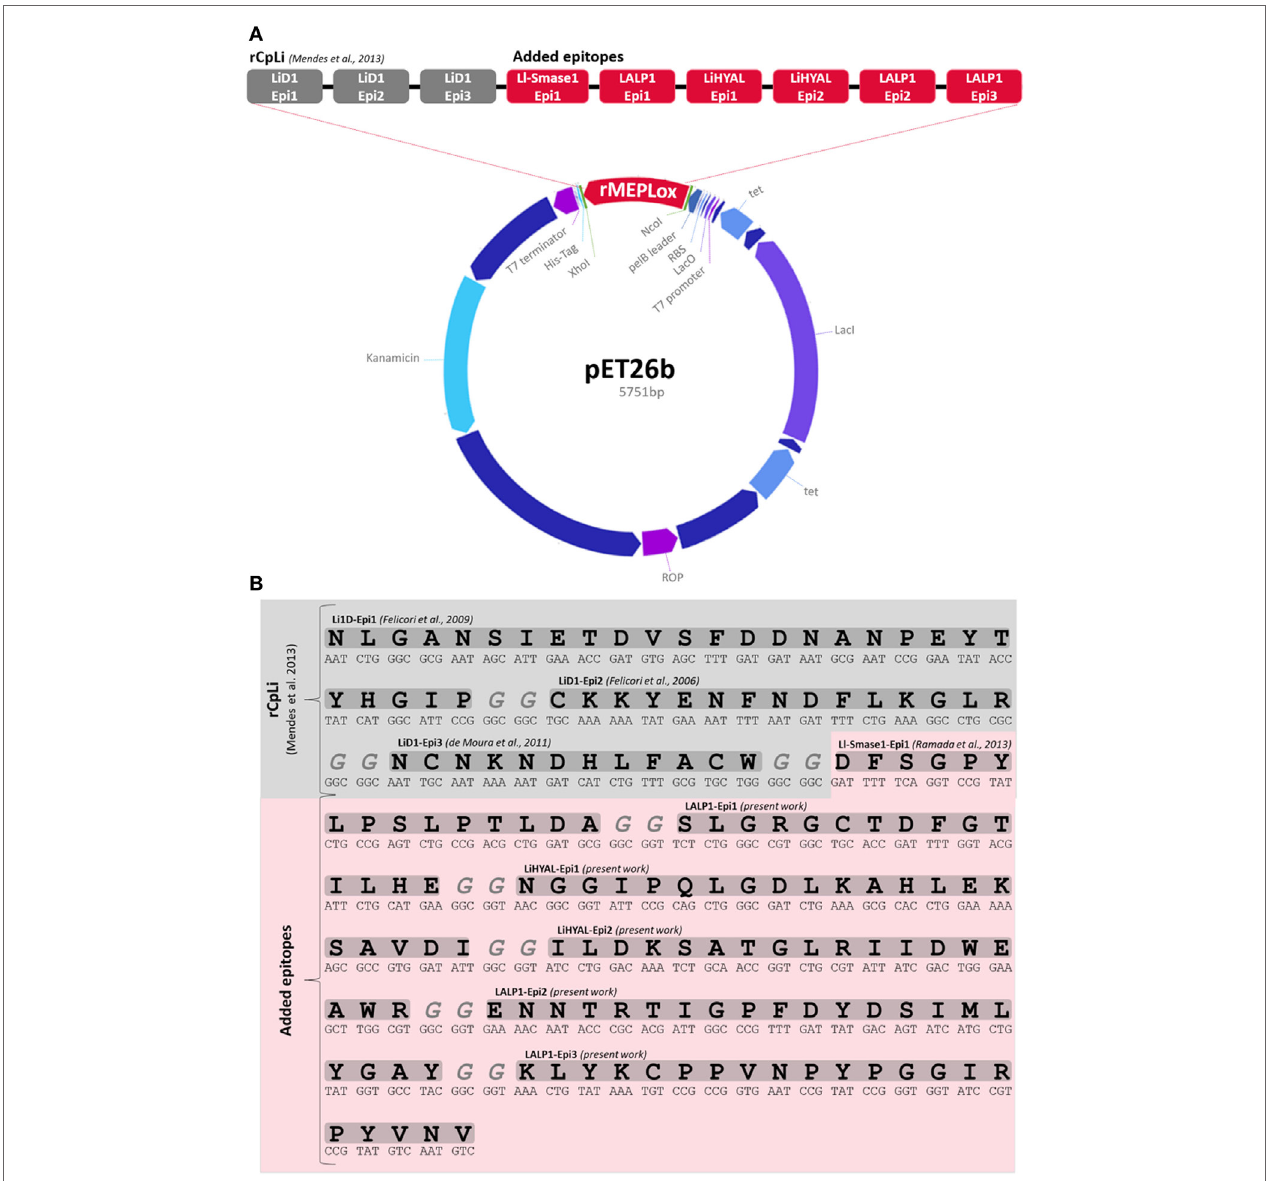
FigUre 3 | Structure of rMEPLox. (a) pET 26 vector structure, showing its main components and the location of rMEPLox and epitope composition of rMEPLox. The first three epitopes from LiD1 in gray composed the previously produced chimeric protein rCpLi. The newly mapped epitopes are marked in red and were placed in the demonstrated order. (B) rMEPLox amino acid and nucleotidic